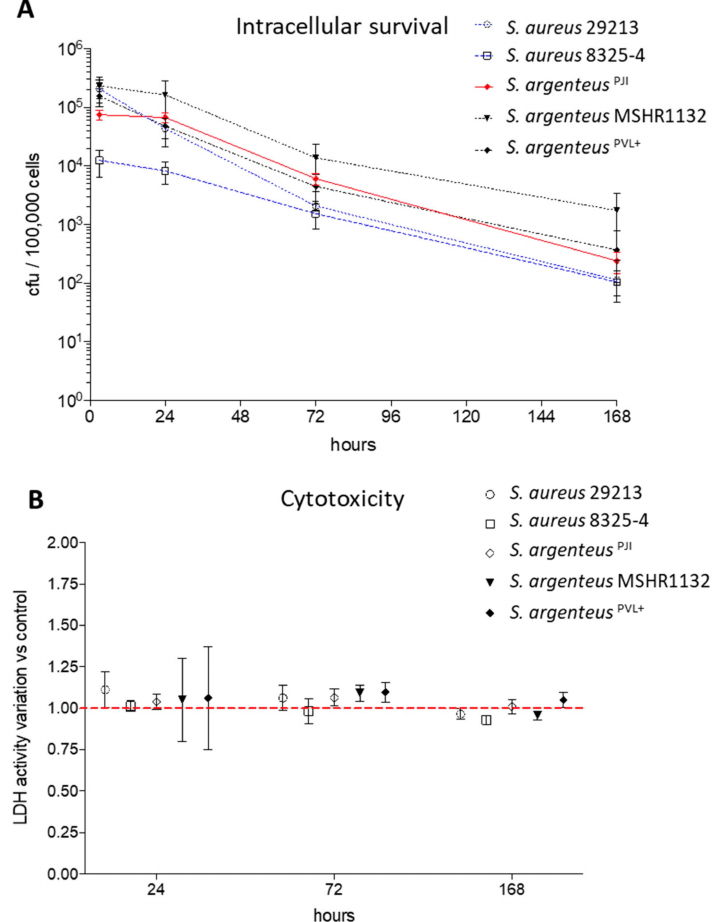
Figure 4. Intracellular survival and cytotoxicity induced by the S. argenteus PJI . ( A ) The intracellular inoculum of S. aureus (29213, 8325-4) and S. argenteus strains ( S. argenteus PJI , S. argenteus MSHR1132, S. argenteus PVL + ) was followed over seven days, expressed in CFU / 100,000 cells, and showed a better persistence for the S. argenteus strains. ( B ) The cytotoxicity induced by the strains has been assessed by following the LDH release in the extracellular medium. The data are presented as variation when compared to the relative non-infected control for each tested time of infection No cytotoxicity is observed for any